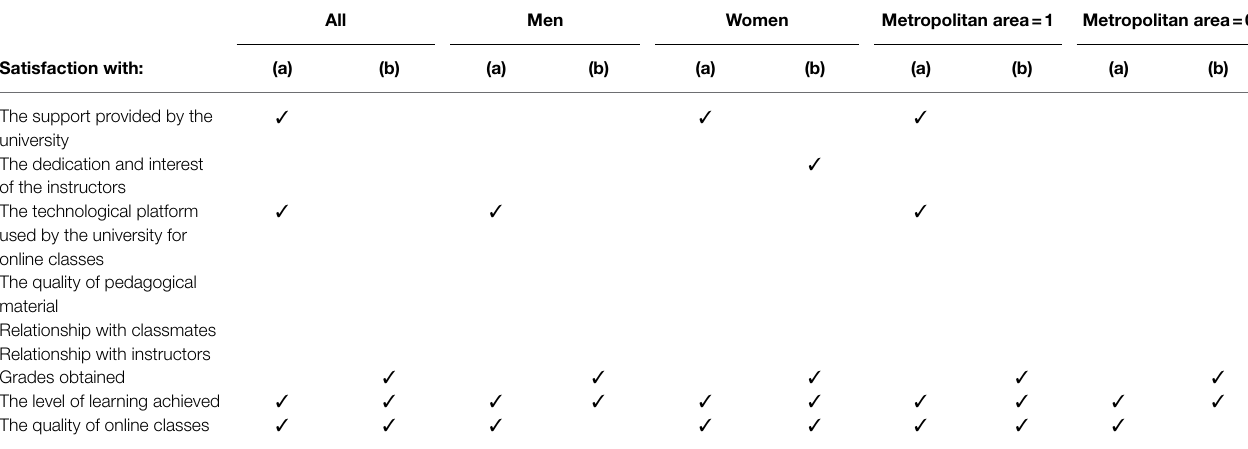
TABLE 6 | Satisfaction with online classes and with academic performance: summary.